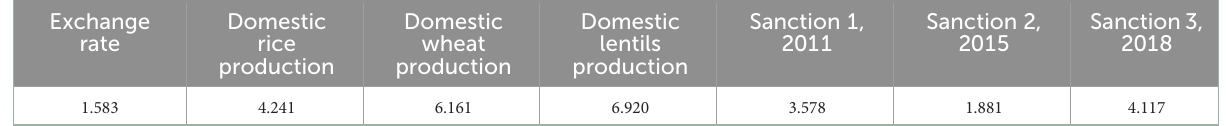
TABLE 3 VIF analysis